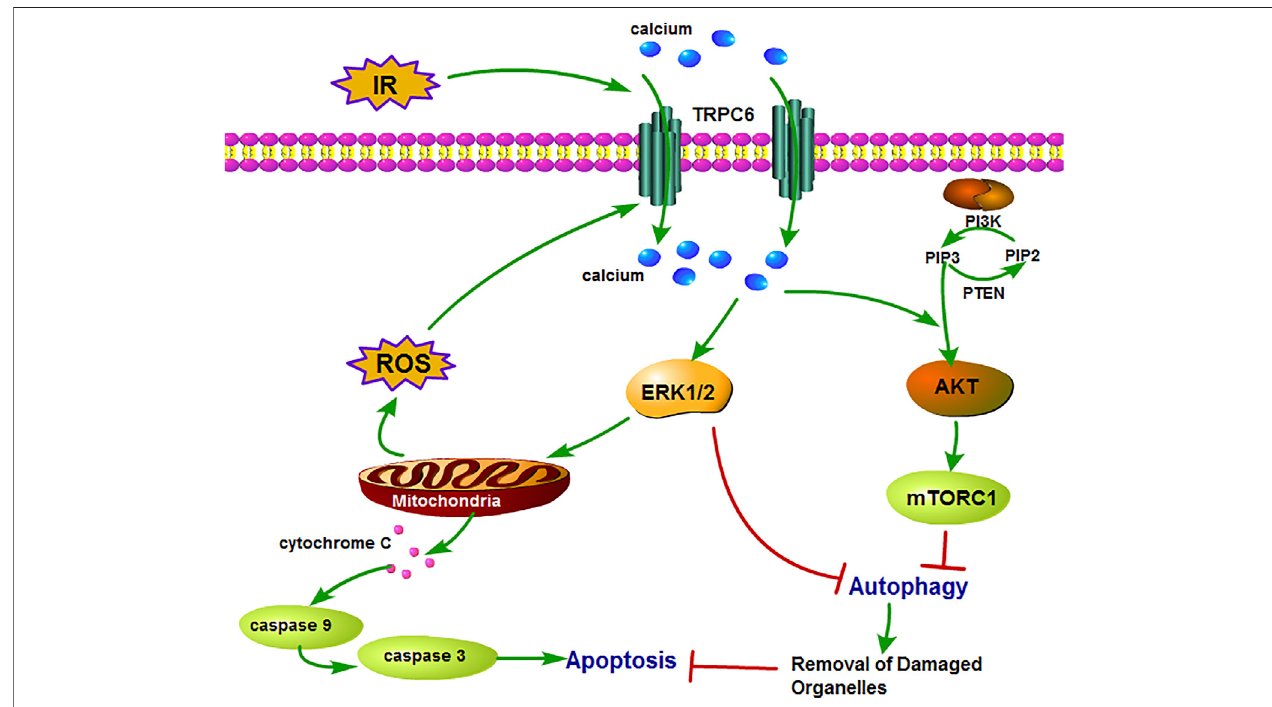
FIGURE 7 | Schematic diagram of mechanism of TRPC6 in renal IRI. TRPC6 is overexpressed during IRI and leads to damaged Ca 2+ in fl ux into TECs, which activates ERK and PI3K/AKT signaling pathways. Then, these two pathways lead to cell apoptosis by inhibiting cytoprotective autophagy which can remove the damaged organelles upon IRI. Moreover, the activation of the ERK pathway induces excessive ROS production from the mitochondria and results in aggravating